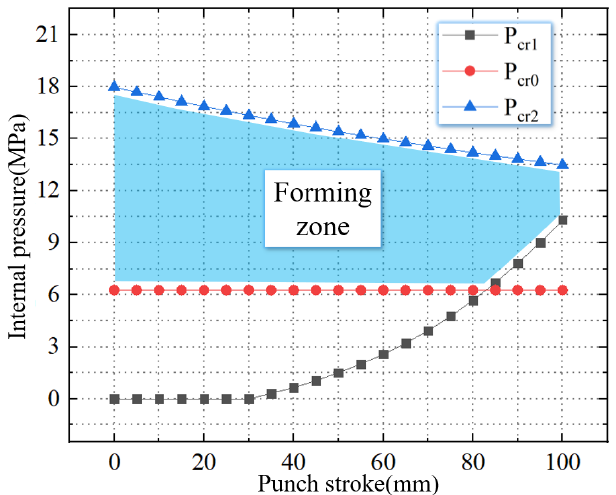
Figure 14. The forming zone of TUBG (thickness-diameter ratio = 1.33%).